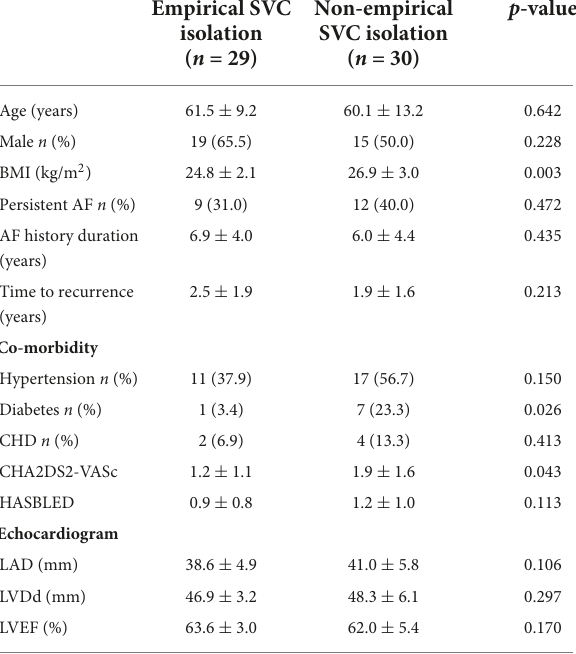
TABLE 2 Demographic and clinical characteristics of empirical and non-empirical superior vena cava (SVC) isolation